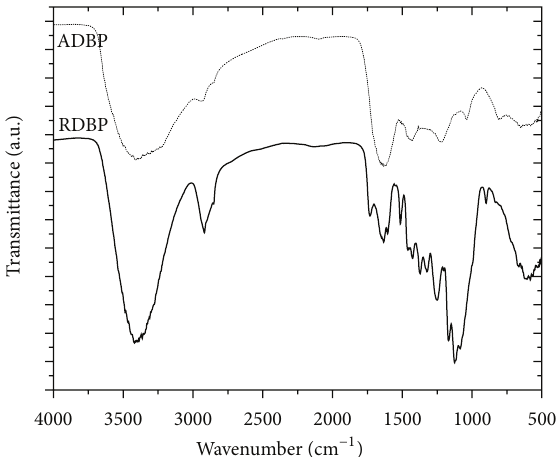
Figure 2: Diffuse reflectance infrared spectroscopy (DFTIR) Raw (RDBP) and Aminated (ADBP) Desmostachya bipinnata